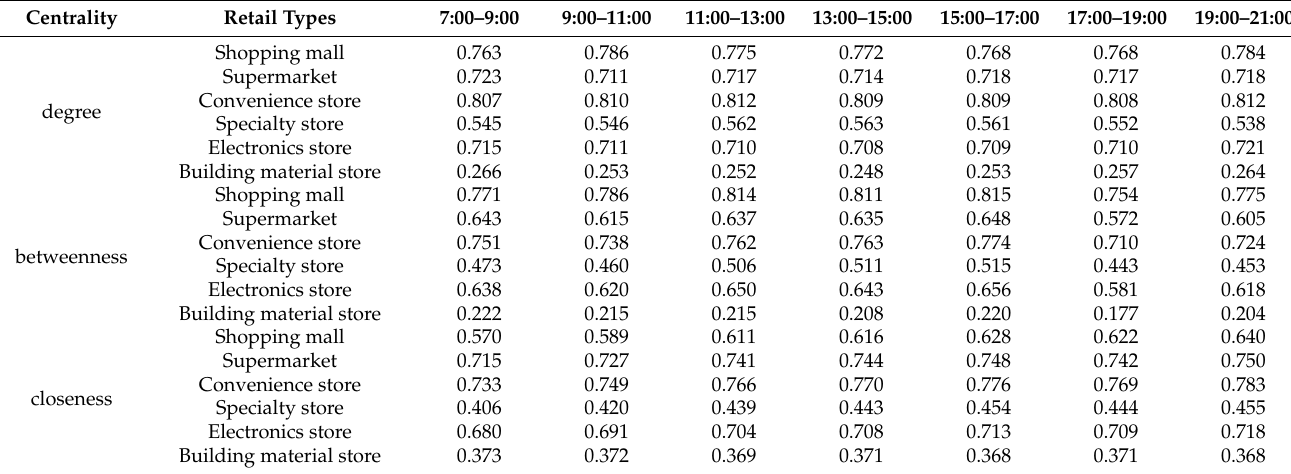
Table 4. Correlation coefficients of KDE values of stores and weighted centrality indices for each period on weekdays. Centrality